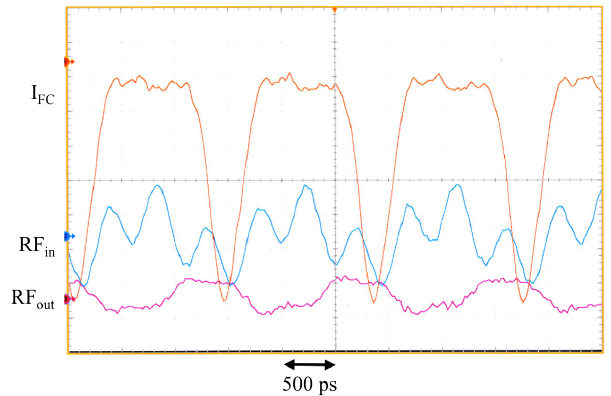
FIG. 5. Measured Faraday cup current, I , for combined first FC and third harmonic modulation of the electron gun. The parame- ¼ (cid:2) 36 kV , V ¼ (cid:2) 90 V , with (cid:1) 540 W at ters are V cathode grid 714 MHz and (cid:1) 450 W at 2142 MHz. The microbunches are 325 ps FWHM (135 ps rms), with 2.81 A peak current and (cid:1) 0 : 91 nC per bunch. Also shown are rf and rf in out